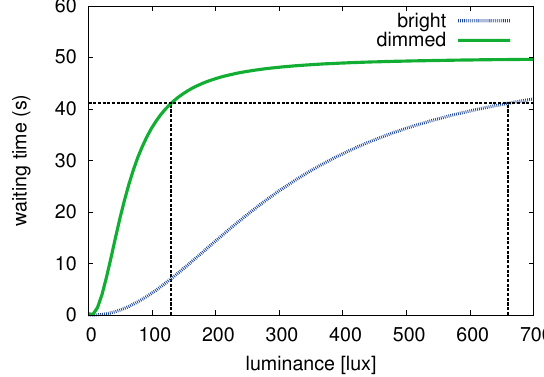
Figure 4: Mapping of luminance values to wait- ing time (equations 1 and 2) for two light settings: bright and dimmed (black lines indicate maximal lu- minance values and w max is 50